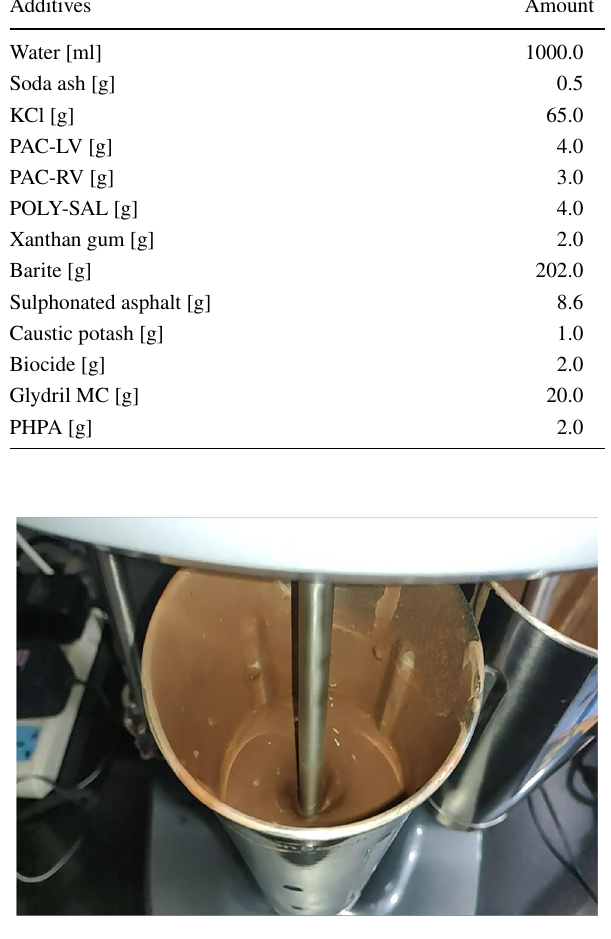
Fig. 2 Hamilton beach mixture during the preparation of mud